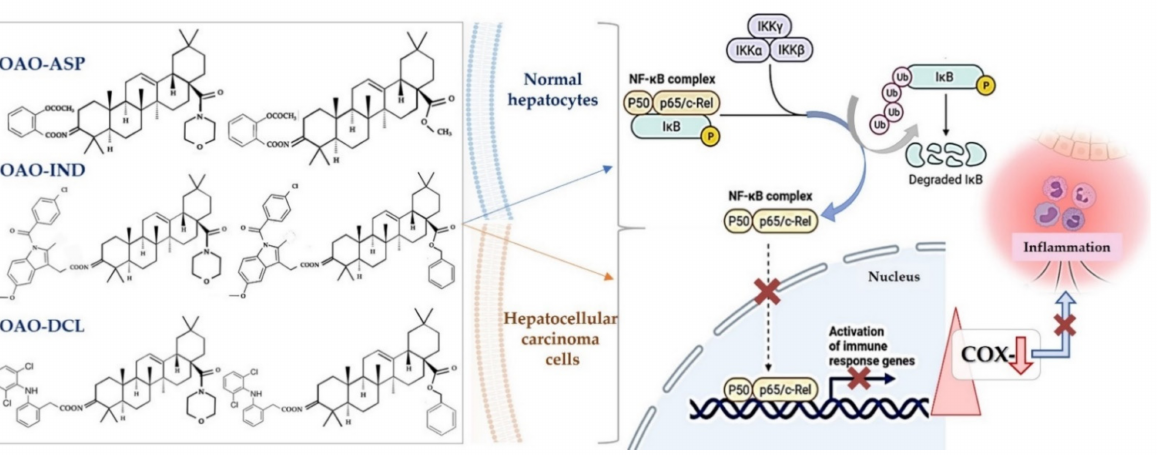
Figure 4. OAO–NSAIDs conjugates reduce NF- κ B activation and expression of COX-2 in normal hepatocytes and HCC cells. OAO–NSAIDs inhibit activation of NF- κ B in normal hepatocytes and in HCC cells by ~50–60% and ~40–50%, respectively [35,39,62]. Figure was created with BioRender.com by the